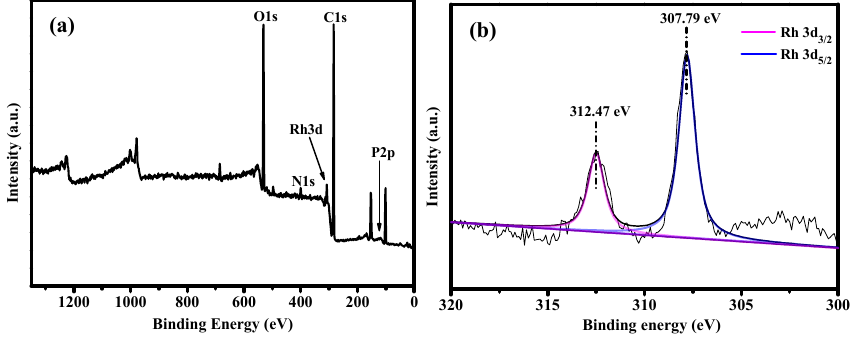
Figure 4. XPS spectra of DAC-BINAP ( a ) and Rh 3d ( b ).